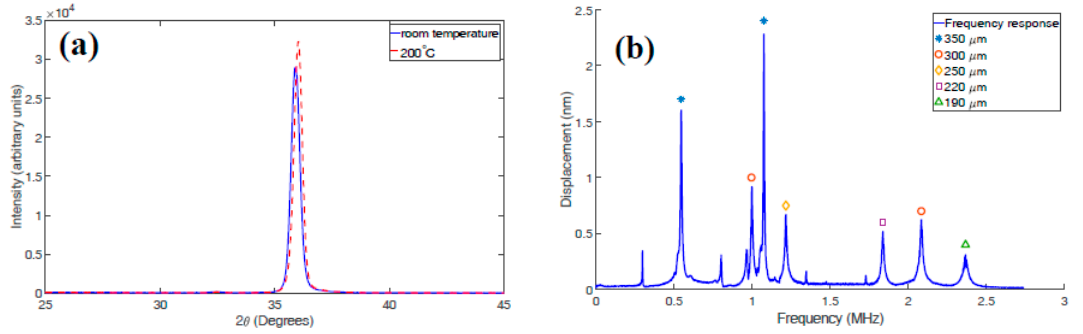
Figure 2. ( a ) The XRD pattern of the deposited AlN at room temperature and 200 °C; ( b ) The LDV measurement of the pMUT array.